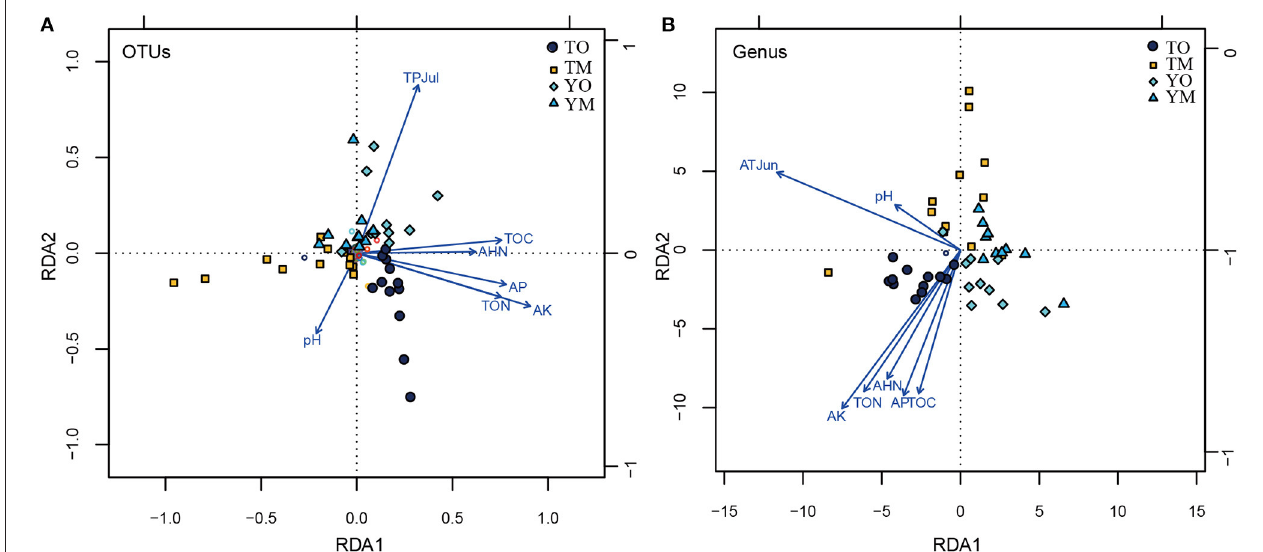
FIGURE 6 | Ordination plots showing the results of the redundancy analysis (RDA) used to explore the relationships between fungal communities and soil properties and climatic variables at the OTU (A) and genus (B) levels. TOC refers to the total soil carbon, TON refers to the total soil nitrogen, AHN refers to the soil alkali-hydrolyzable nitrogen, AP refers to the available phosphorus, and AK refers to the soil available potassium. TPJul refers to the total precipitation of July at the site. pH refers to soil pH value. TO represents the O horizon at Tiantangzhai Nature Reserve. TM represents the M horizon at Tiantangzhai Nature Reserve. YO represents the O horizon at Yaoluoping Nature Reserve. YM represents the M horizon at Yaoluoping Nature